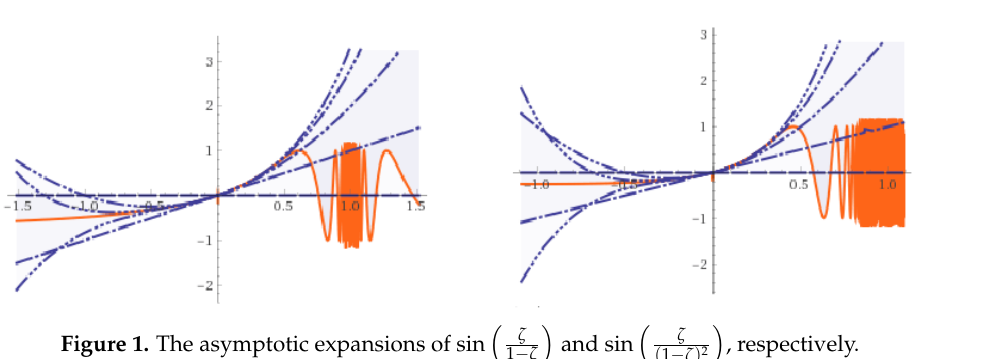
Figure 1. The asymptotic expansions of sin